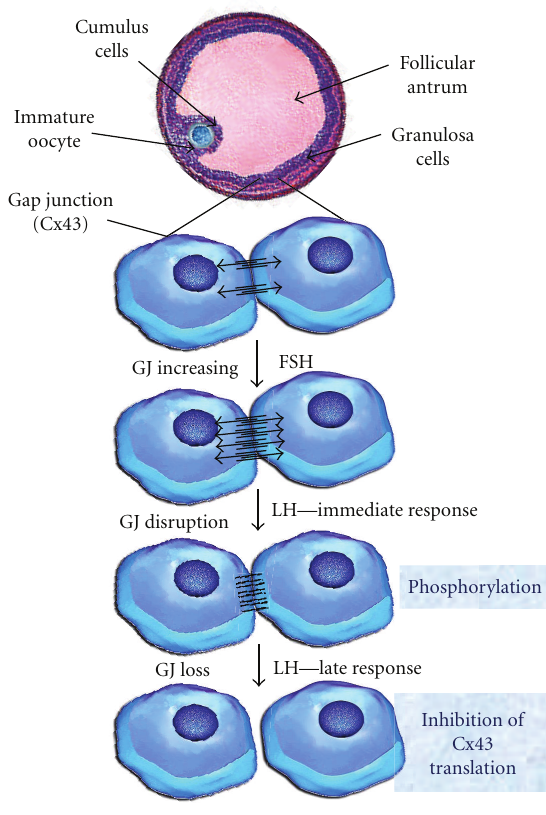
Figure 3: Model of regulation of gap junctional communication ( GJ , Cx43) [6, 8, 9] During development of the antral follicles FSH hormone stimulates mRNA expression that codifies the Cx43 synthesis of the GJs, the amplification of functional channels, and consequently the integration to the metabolic activity [8]. Mediated by the family mitogen-activated protein kinases, preovulatory LH levels interrupt cell-cell communications by means of phosphory- lation and modification of Cx43 protein conformation. This leads to interruption of the intercellular channels. The primary e ff ect of the immediate response to LH is accompanied by elimination of the Cx43 protein, disappearance of GJ sand separation of the GCs from the oocyte. GJ: gap junction; GC: granulosa cells. With permission from N.